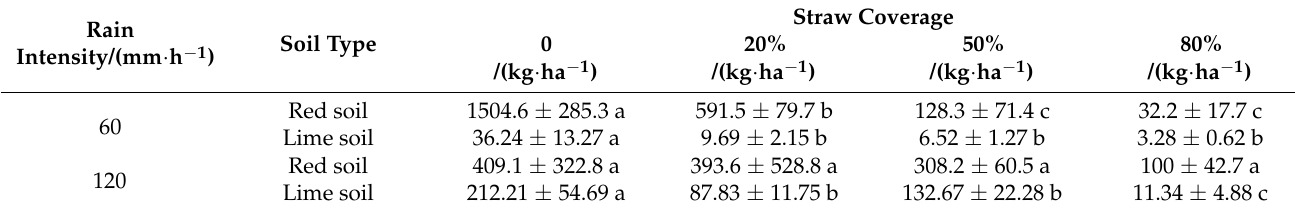
Figure 3. Surface runoff reduction rate of red soil and lime soil at 60 mm/h ( a ) and 120 mm/h ( b ) rainfall intensities with different straw coverages. (The surface runoff reduction rate refers to the ratio of the difference between the total surface runoff without straw mulch, minus the total surface runoff with straw mulch, to the total surface runoff without straw mulch). Table 3. Surface erosion of red soil and lime soil with different straw